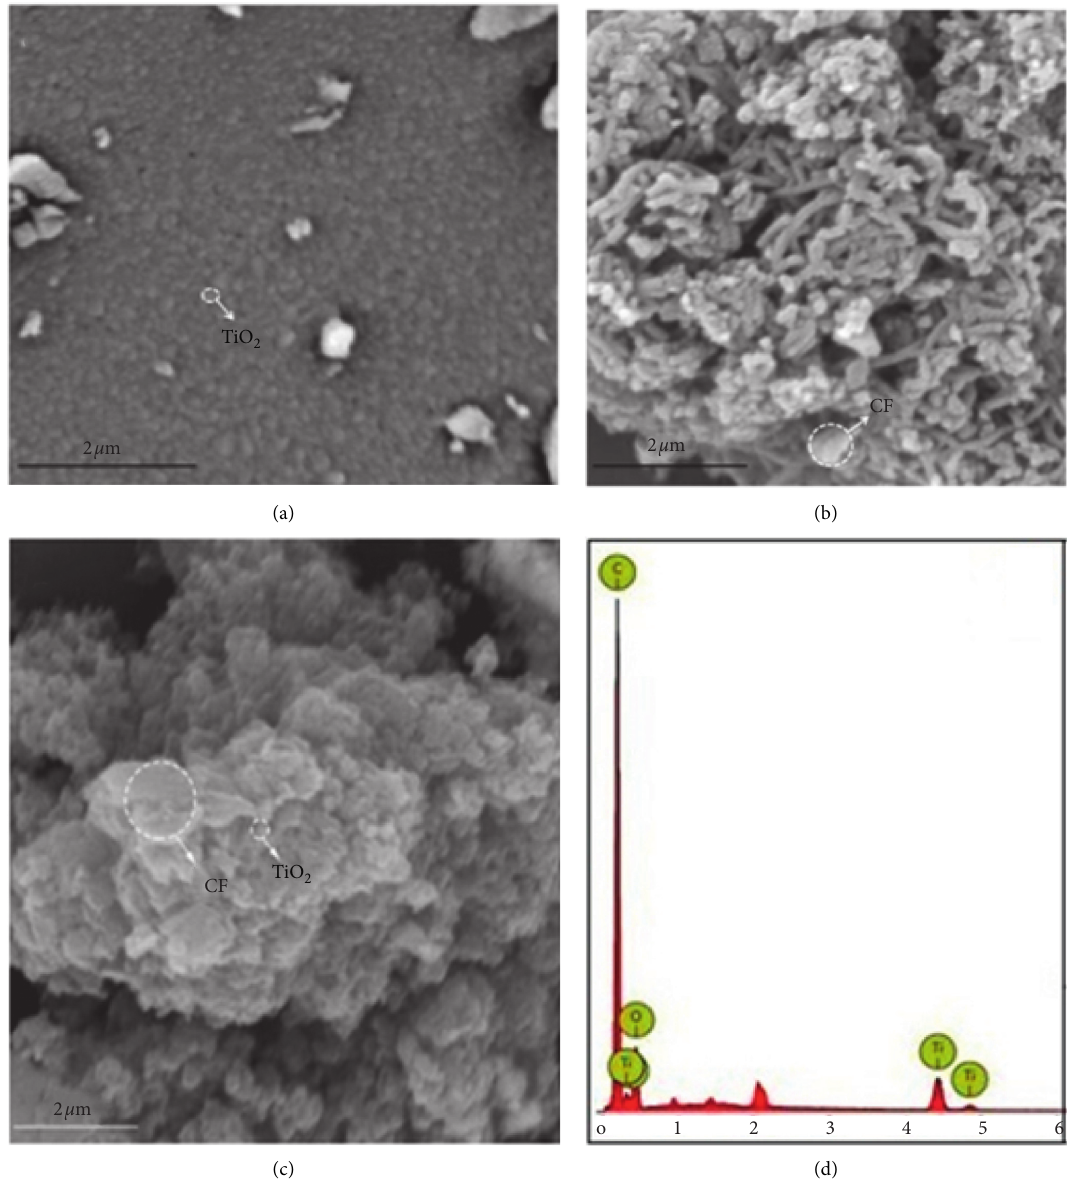
Figure 2: SEM images of (a) TiO